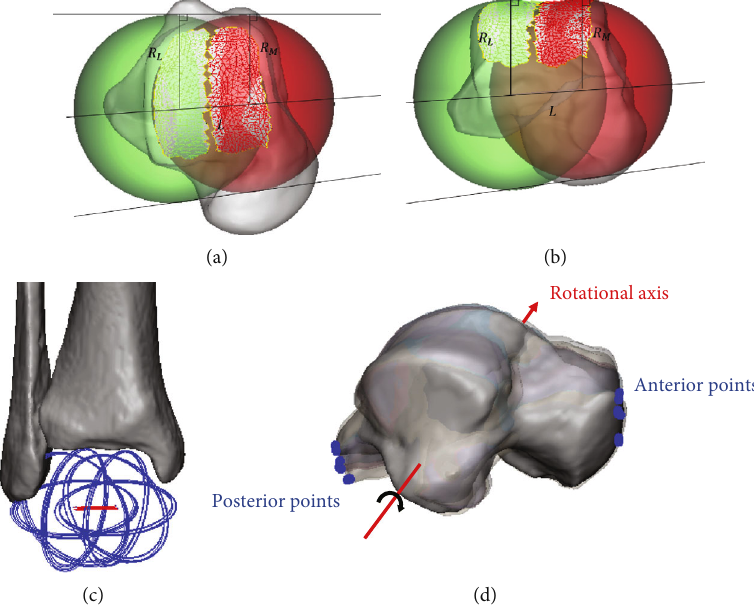
Figure 2: (a) Top view and (b) front view of the measurement of the parameters of fi tting spheres (the radius of the lateral sphere R radius of the medial sphere R M , the distance between sphere origins L ), (c) fi tting spheres and the geometric axes of each talus at all poses, (d) an illustration of the most anterior point at the navicular articular surface and the most posterior point at the posterior process of each talus at all